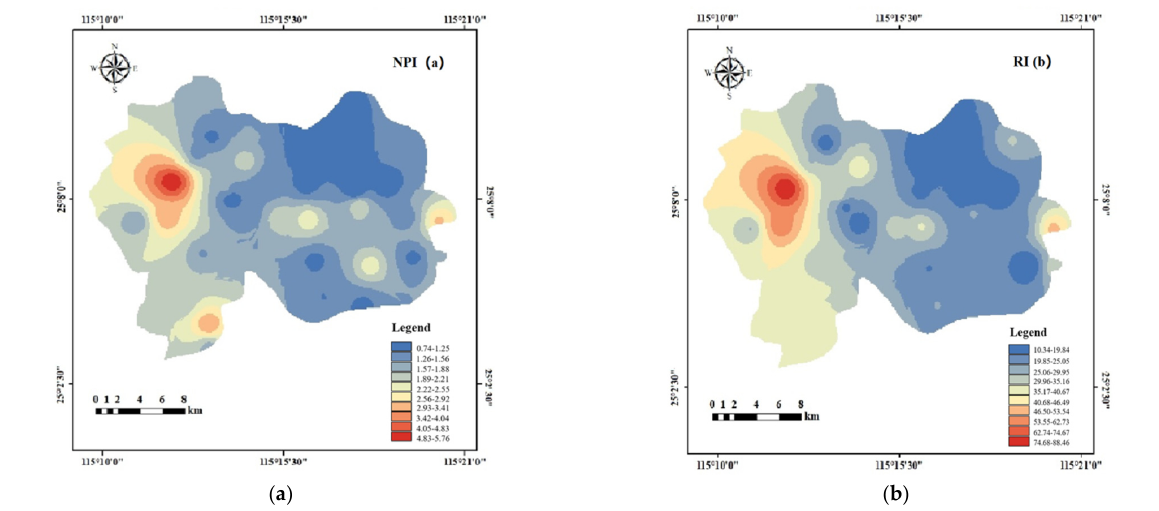
Figure 4. Class distribution of soil potential ecological risks in the study area. ( a ) Distribution of Nemerow integrated pollution index for soils in the study area. ( b ) Distribution of potential ecological risks index for soils in the study area.